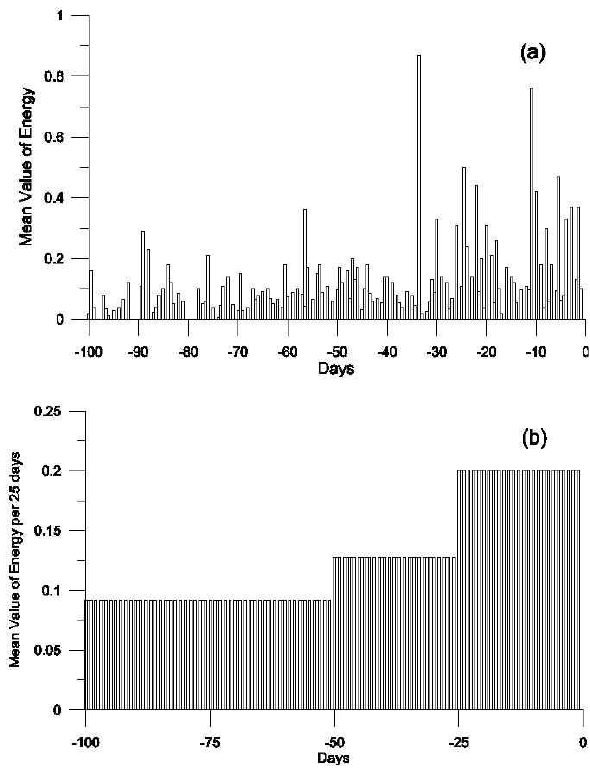
Fig. 4. (a) The mean value of energy for signals corresponding to data recorded by the DEMETER satellite during its night-passing Figure 4 . a) The mean value of energy for signals corresponding to data which were covering a time interval of 100 days before the strong Earthquake. recorded by DEMETER satellite during its night-passing covering a time interval of As we can see in this figure, many significant increases in the mean 100 days before the strong Earthquake. As we can see in this Figure many significant increases in the mean value of the energy are observed in a time period of one month value of the energy are observed in a time period of one month before the main Earthquake. b) The mean value of energy of pre-earthquake signals before the main Earthquake. (b) The mean value of energy of pre- per 25. The most significant change of energy is observed for the time interval 0-25 earthquake signals per 25. The most significant change of energy is days before the earthquake. observed for the time interval 0–25 days before the